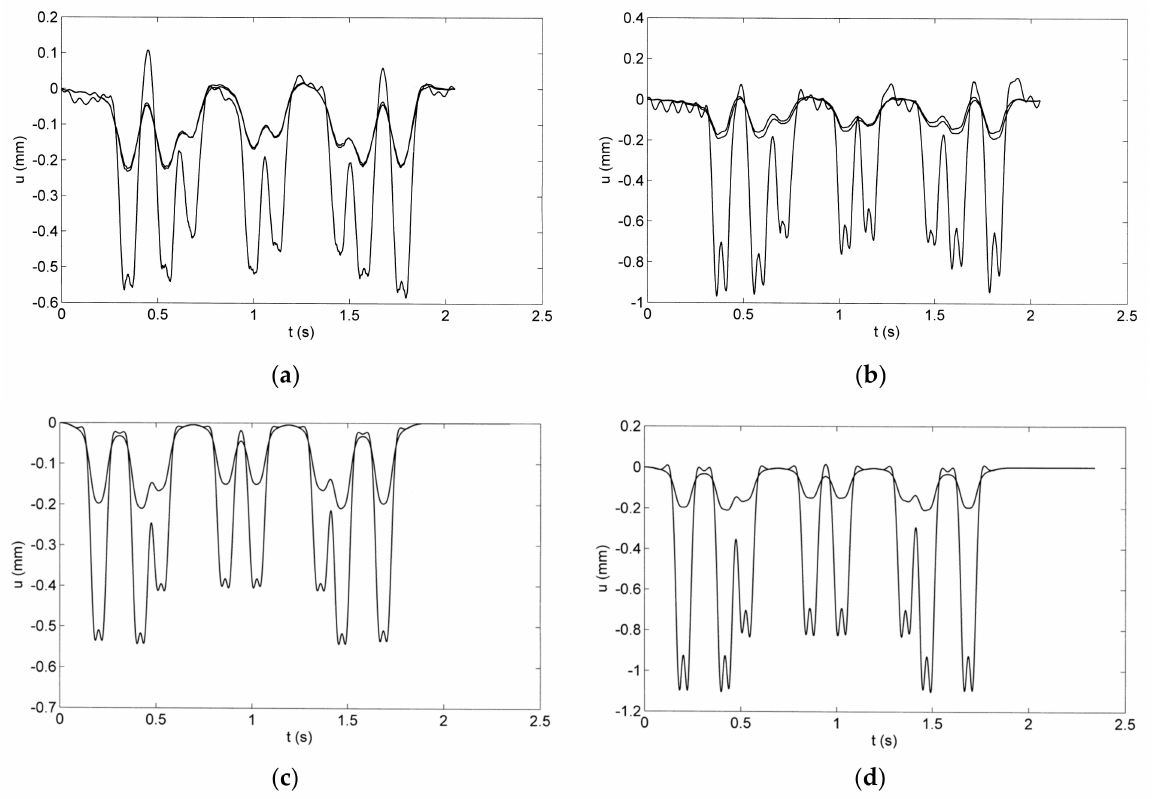
Figure 14. Track-slab, base-plate, and base-layer displacements of the floating-slab track at Site S under the passage of a short 4-unit ICE test train, measurement ( a , b ) and calculation (( c , d ) FEBEM results), ( a , c ) at the middle and ( b , d ) at the end of the 6 m long track segment.